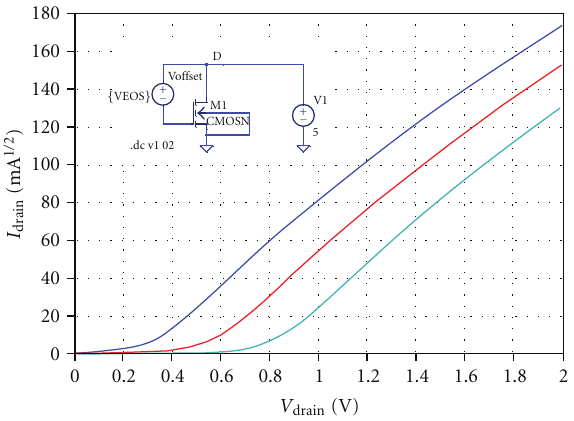
Figure 3: Extraction of V t and K n using a diode-connected transistor. Note that the o ff set potential produced by the reference electrode is incorporated into the estimate for threshold voltage used for design purposes. The o ff set voltages are − 0.250 mV (blue line), 0V (red line), and +0.250 mV (green line). The V t of the simulated device is 0.57